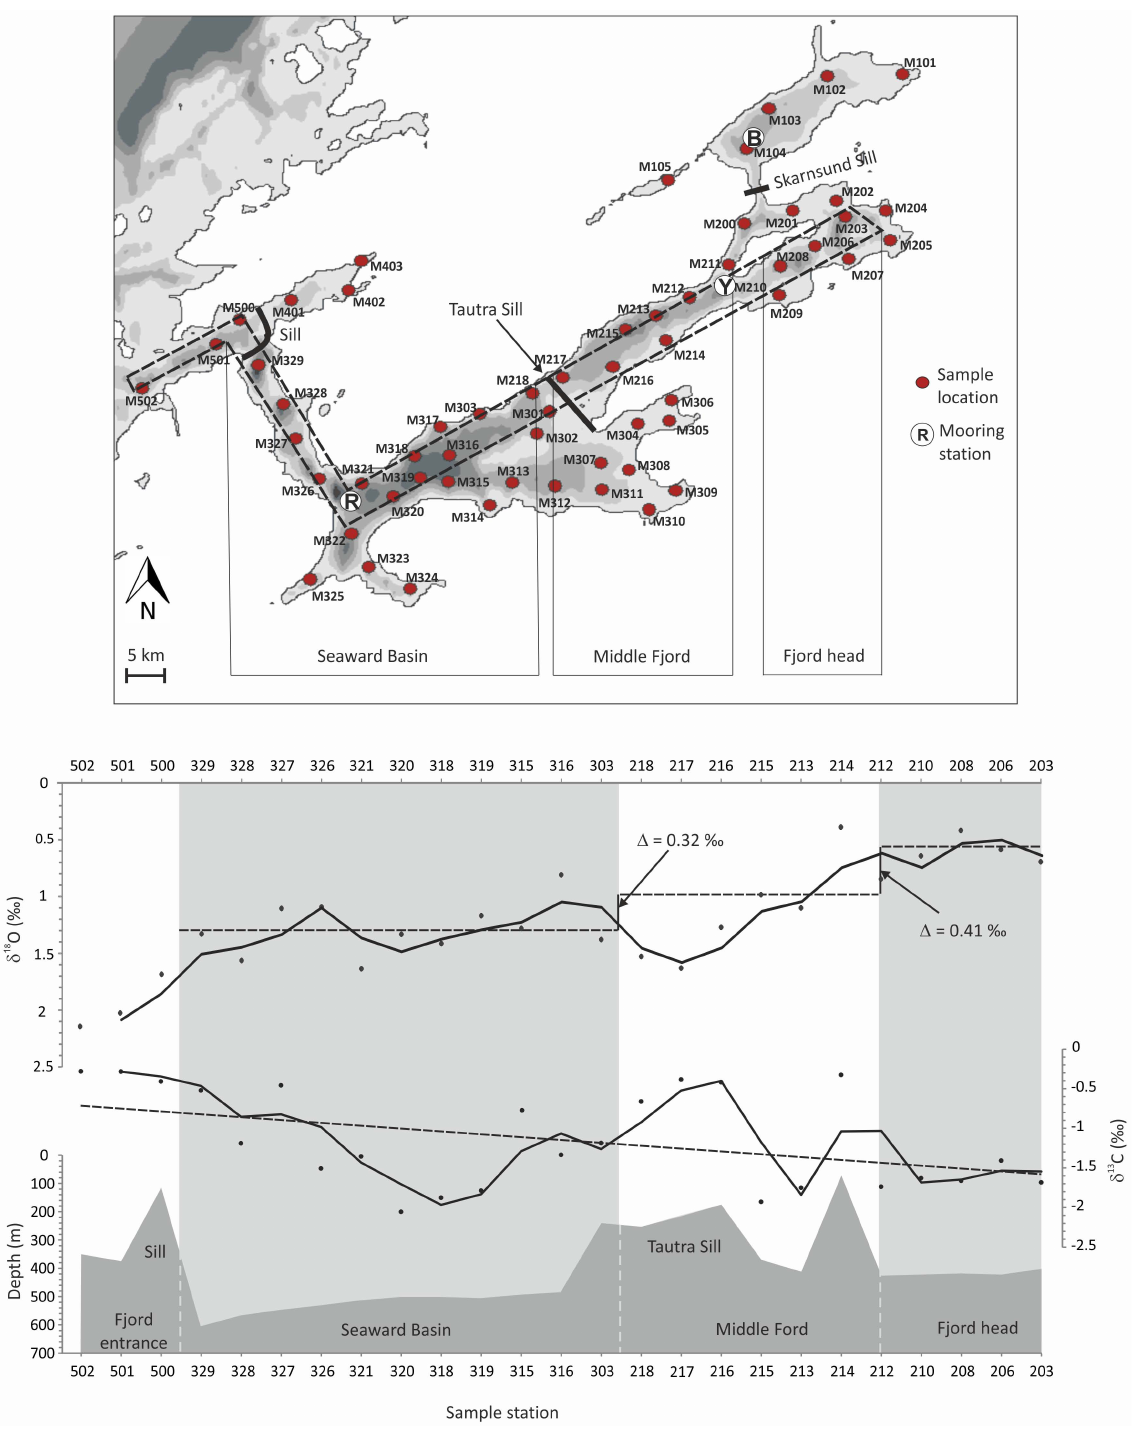
Fig. 4. Top: bathymetric overview with sample locations and fixed mooring stations at Røberg, Ytterøy and Beitstad. The dashed frame marks the sample locations which are displayed below; bottom: cross section of the benthic foraminiferal stable isotope ratios along the fjord axis, top: δ 18 O; bottom: δ 13 C; black lines correspond to the two point average of the